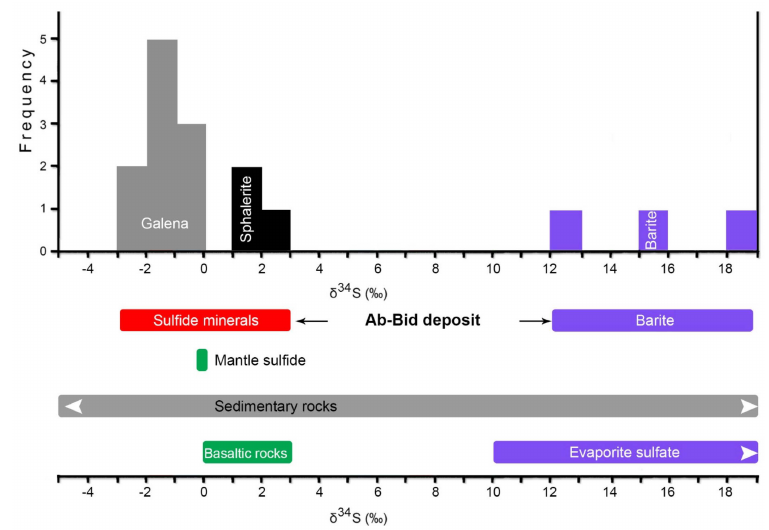
Figure 13. Histogram of δ 34 S values for sulfides and barite from the Ab-Bid deposit in comparison with δ 34 S values of evaporite sulfate, mantle sulfide, basaltic, and sedimentary rocks [19]. The δ 34 S values of sulfides from the Ab-Bid deposit show a relatively narrow range of variation, from − 2.1 to +2.5‰, with an average of − 0.8‰. Three barite samples from the western vein of the New Mine gave δ 34 S-enriched values, between +12.3 and +18.2‰.